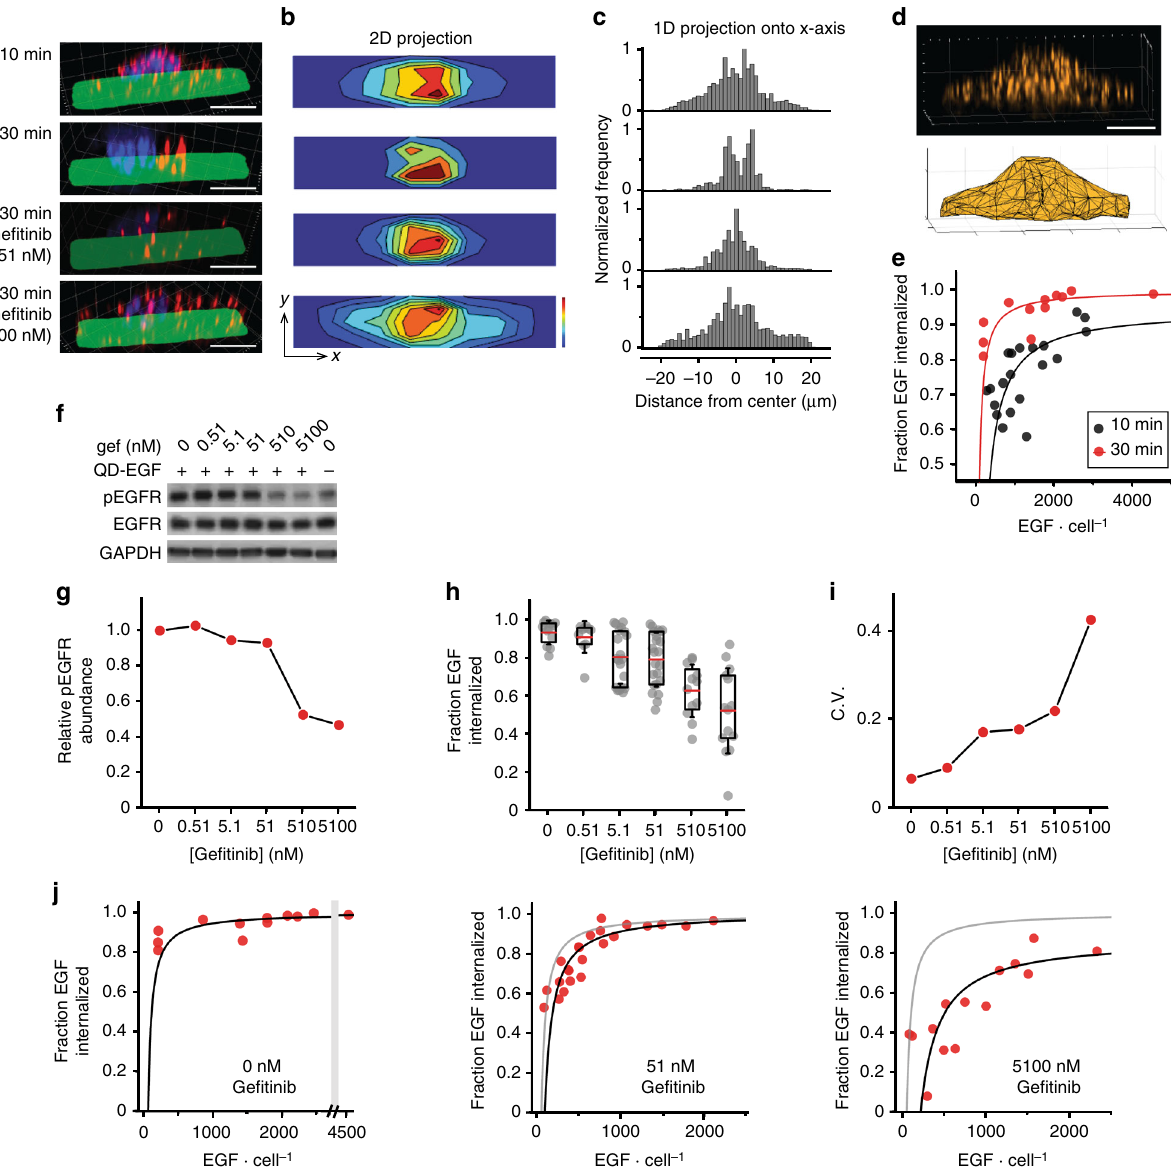
Fig. 5 Single-cell epidermal growth factor (EGF) binding correlates with single-cell receptor translocation and drug response. a Representative three- dimensional (3D) images of MDA-MB-231 cells after stimulation with quantum dot-EGF (QD-EGF) in the absence or presence of EGFR inhibitor ge fi tinib. Times after the start of a stimulation pulse are indicated. QDs are shown in red, nuclei are blue, and Alexa Fluor 488-conjugated fi bronectin micropatterns are green. b Two-dimensional (2D) z -projections on xy fi bronectin micropattern planes and c one-dimensional (1D) projections on x -axes indicate the localization of single EGF averaged across cells. d Representative image of cell membrane measured through fl uorescence imaging of fl uorescently labeled receptors (top) and membrane reconstruction using alpha shapes (bottom). e Correlation between EGF number and fraction of EGF internalized in individual cells at 10 and 30 min after the start of a QD-EGF stimulation pulse. f Western blots and g relative pEGFR abundance in MDA-MB-231 whole-cell lysates immediately after stimulation with QD-EGF in the presence of indicated ge fi tinib concentrations. Uncropped western blots with molecular weight markers are shown in Supplementary Figure 16. h Fraction of EGF internalized in single cells at different ge fi tinib concentrations, 30 min after the start of a QD-EGF pulse. The box indicates 25/75th percentile; red lines are means; whiskers are s.d. i Coef fi cient of variation (CV) of the fraction of EGF internalized in h . j Number of EGF bound impacts the fraction of EGF internalized 10 min after the start of a QD-EGF pulse in the presence of ge fi tinib at 0, 51, and 5,100nM concentration. The gray line shown in 51 nM (middle) and 5100 nM (right) ge fi tinib plots is the linear fi t for 0 nM ge fi tinib condition (left). Data fi ts are shown in Supplementary Figure 14. N = 20 and 12 cells for 10 and 30 min after QD-EGF stimulation onset without ge fi tinib, respectively; N = 12, 10, 20, 23, 12, and 14 cells for 30 min after QD-EGF stimulation onset in the presence of ge fi tinib at 0, 0.51, 5.1, 51, 510, and 5100 nM concentrations, respectively. All stimulation pulses used 1 nM EGF-QD for 5 min. All scale bars indicate 10 µ